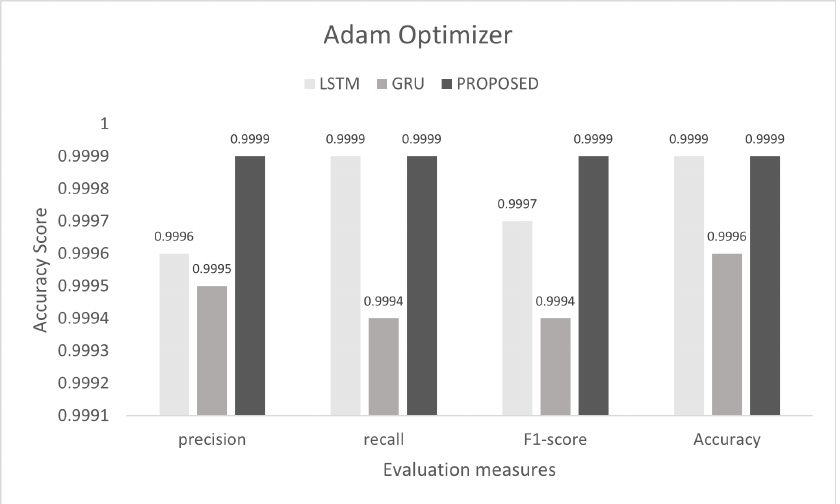
Figure 14. Evaluation on Adam with the car-hacking dataset.